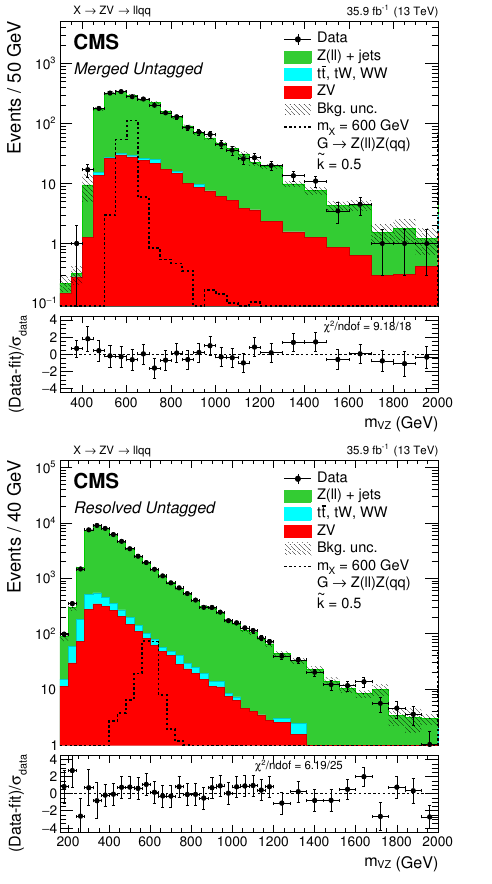
Figure 5 . The signal region m VZ distributions for the low-mass search, in the merged V (up- per), resolved V (lower), untagged (left), and tagged (right) categories, after (cid:12)tting the signal and sideband regions. Electron and muon categories are combined. A 600 GeV bulk graviton signal prediction is represented by the black dashed histogram. The gray band indicates the statistical and post-(cid:12)t systematic uncertainties in the normalization and shape of the background. Larger bin widths are used at higher values of m VZ ; the bin widths are indicated by the horizontal error bars. is taken from simulation, a 5% uncertainty in the cross section is used, which is extracted from the recent CMS measurement of top quark pair production in dilepton events